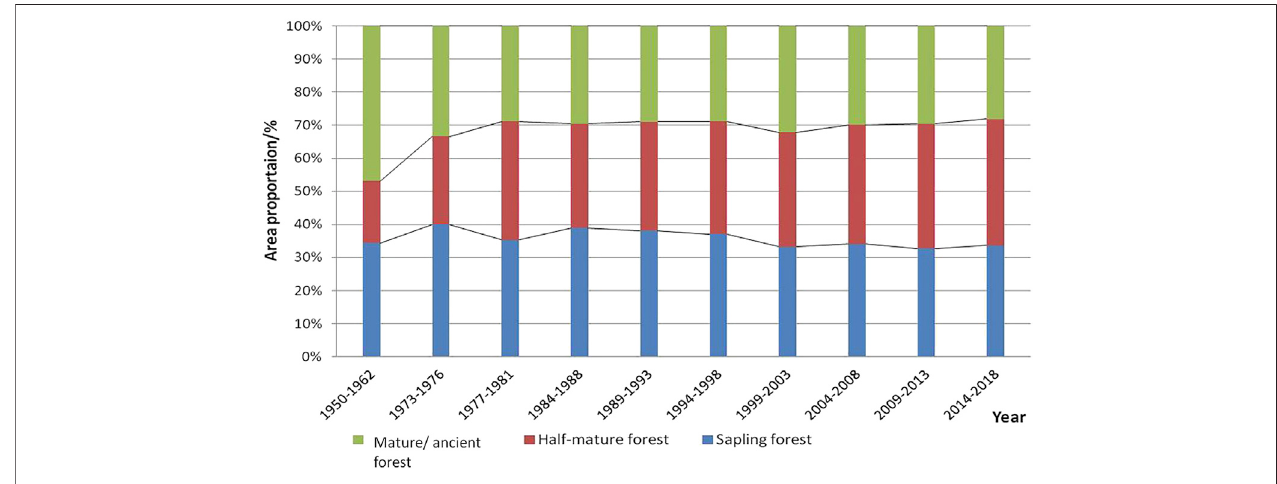
FIGURE 8 | Forest area proportion of different age-groups.